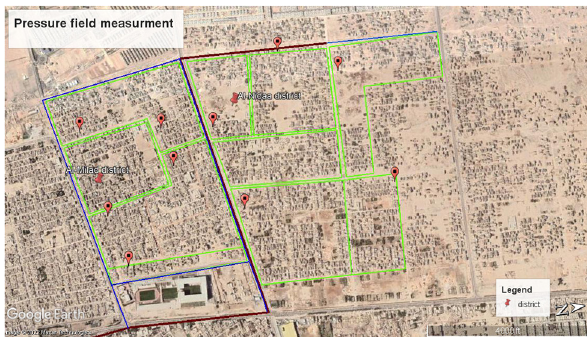
Figure 3: The locations of fi eldwork measurements.